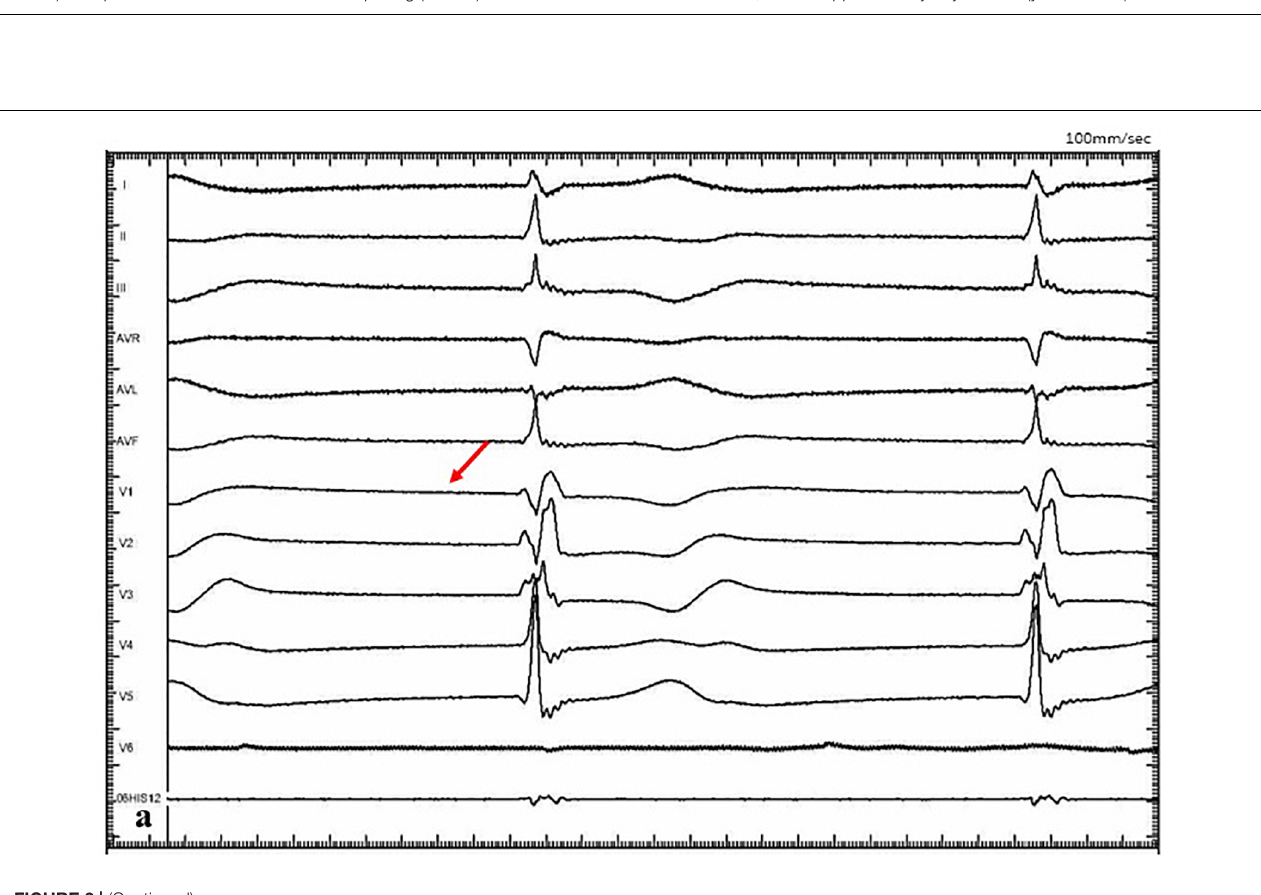
FIGURE 2 | Intraoperative X-ray fluoroscopy images. (a) CRA 0, LAO 0; (b) CRA 0, RAO 28. The temporary pacemaker lead was coiled in the right atrial lumen (red arrow). The position of left bundle branch area pacing (LBBaP) was at the distal end of the ventricle, 1.5 cm approximately beyond HIS (yellow